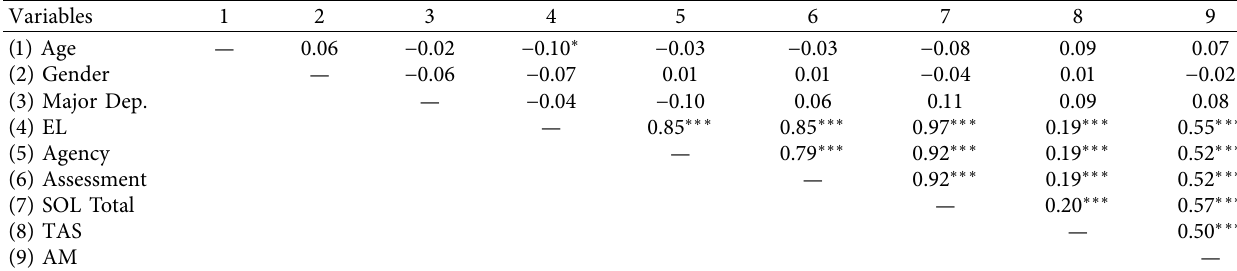
Table 2: Intercorrelation of students’ satisfaction with online learning, teachers’ academic support, and academic motivation of the undergraduate students ( N � 406).